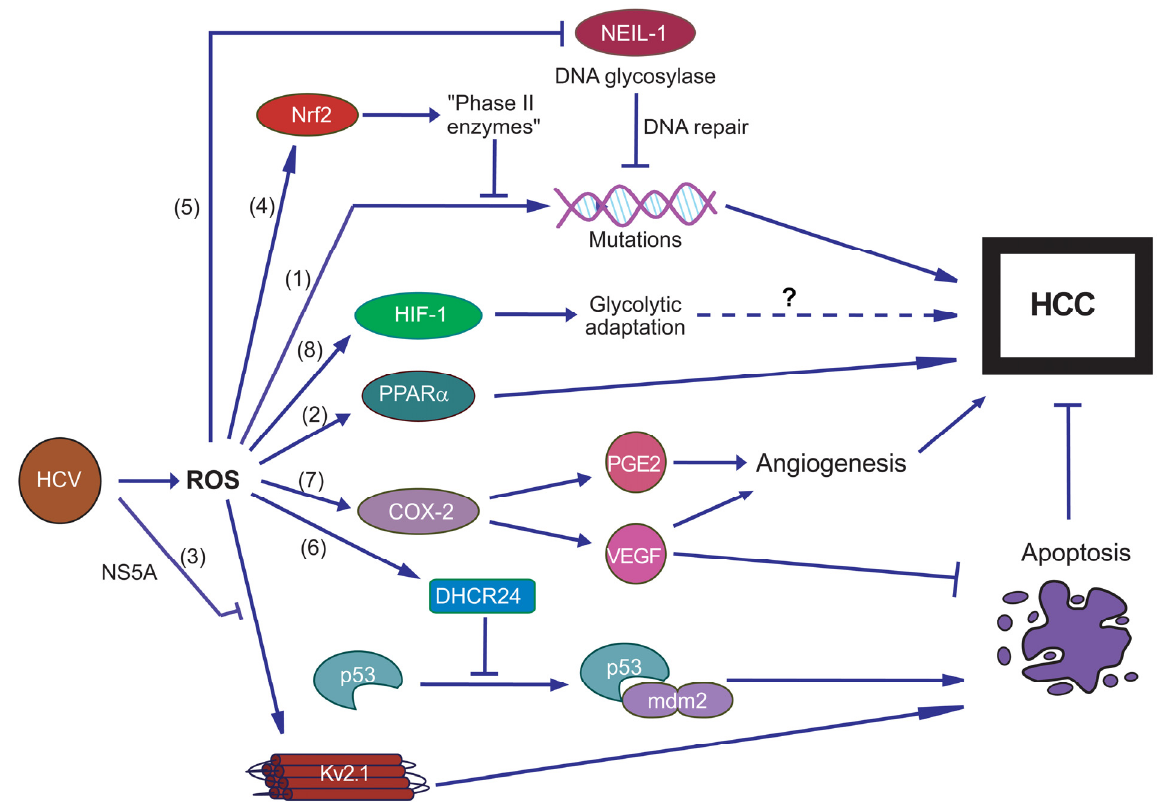
Figure 2. Diagram representing possible mechanisms linking HCV-induced oxidative stress with hepatocarcinogenesis. They include accumulation of DNA damage in response to ROS augmented by suppressed reparation processes (down-regulation of NEIL-1 DNA glycosylase) with concomitant activation of antiapoptotic Nrf2/ARE antioxidant defense pathway. HCV-induced oxidative stress also favors tumor development by enhancing HIF-1 — driven glucose uptake and glycolytic adaptation, regulated by hypoxia-inducible factor 1 (HIF-1) as well as by promoting angiogenesis through activation of cyclooxigenase 2 (COX-2) which caused enhanced biosynthesis of prostaglandin E2 (PGE2) and vascular endothelial growth factor (VEGF). In addition, ROS-mediated activation of peroxisome proliferator-activated receptor α (PPAR α ) as well as blockage by NS5A of proapoptotic potassium ion channel Kv2.1 may also contribute to